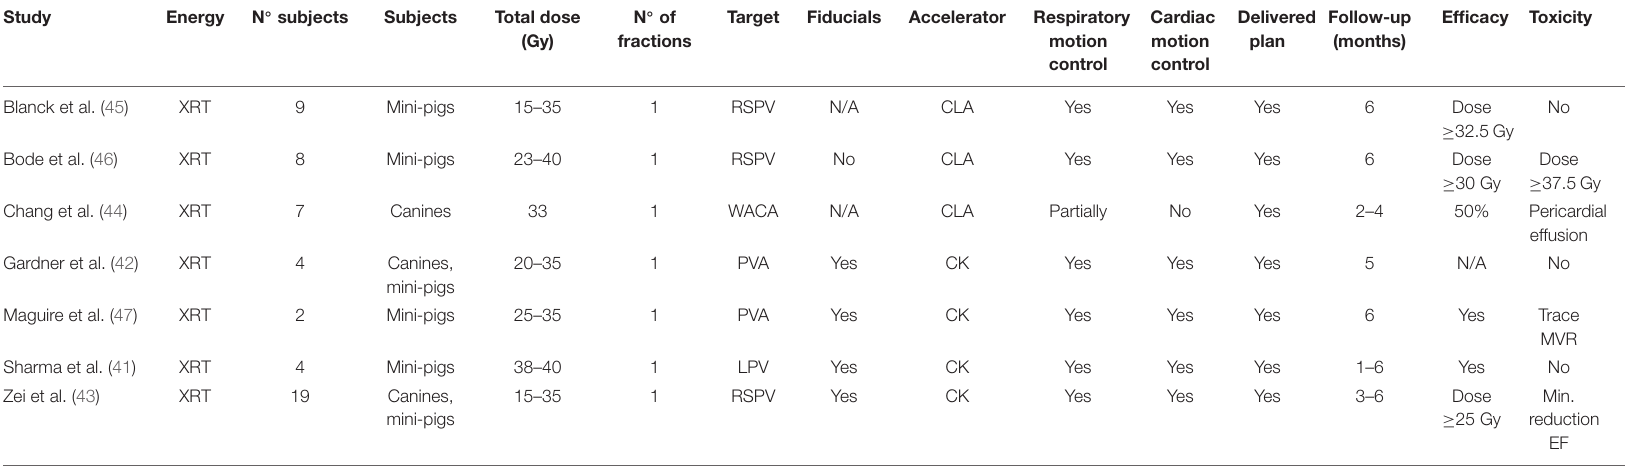
TABLE 1 | Main characteristics of the preclinical studies on animals included in the analysis.